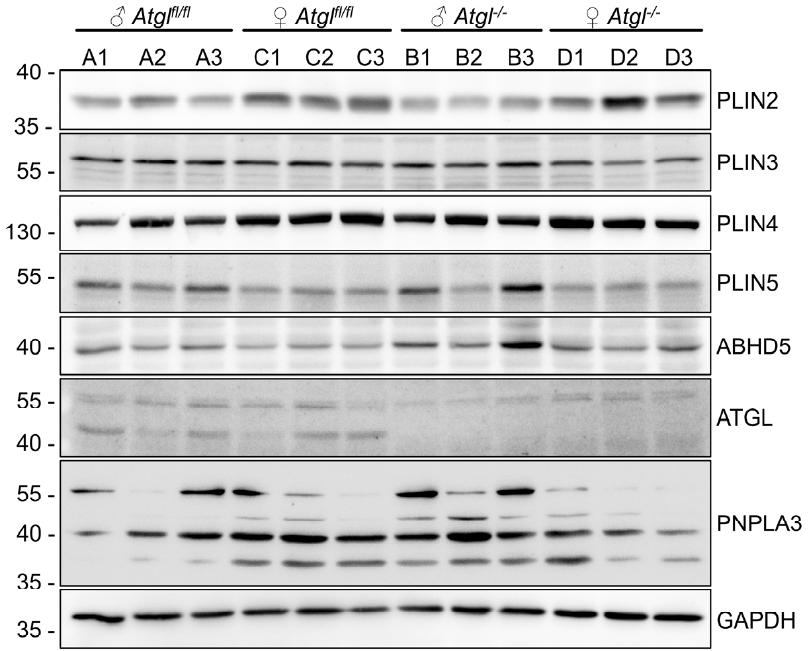
Figure A9. Perilipin 2-5, ATGL, and PNPLA3 in ATGL knockout mice of 8 weeks age. Immunoblot analyses of perilipin 2, 3, 4, and 5 (PLIN2, 3, 4, 5), ABHD5, ATGL, and PNPLA3 from whole cells liver lysates of floxed or ATGL knockout mice. Three mice per group were analyzed. GAPDH served as loading control. Molecular weight in kDa is shown on the left side.